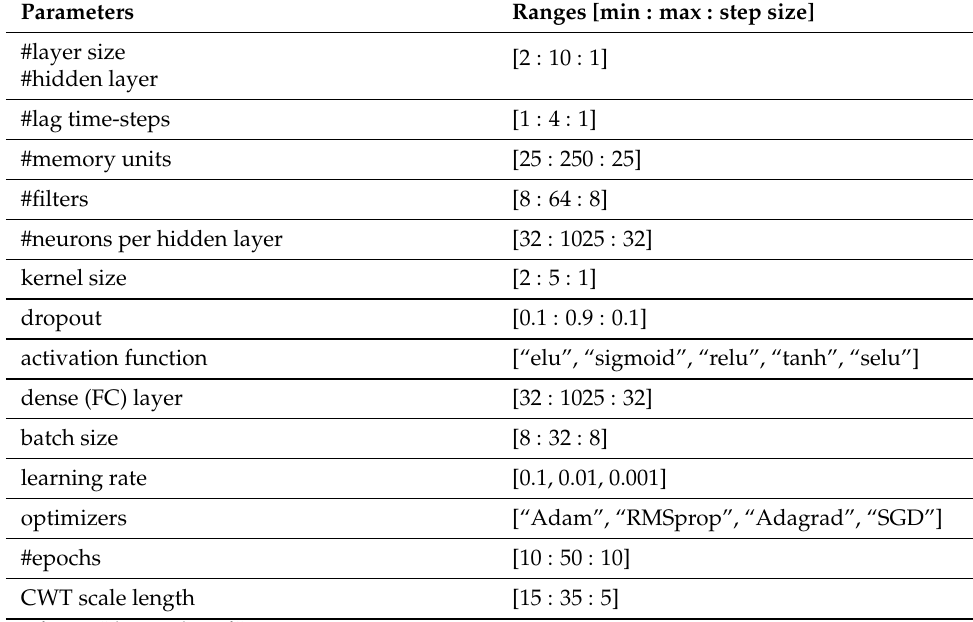
Table 1. Hyperparameters with a specified range of